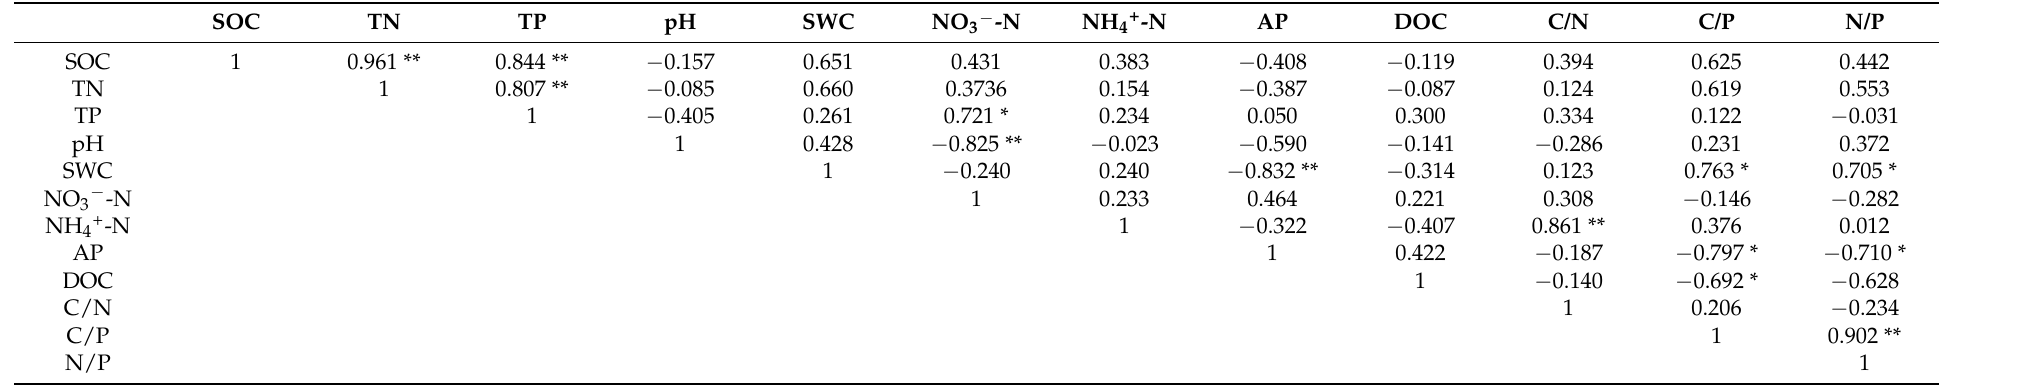
Table A2. Correlation analysis between environmental